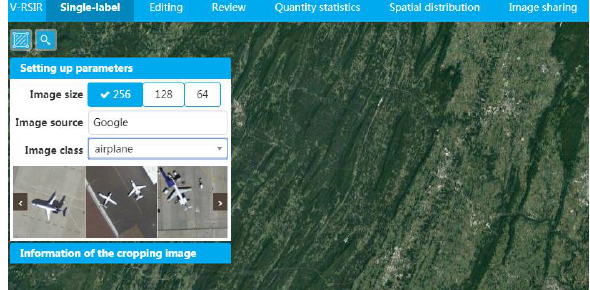
Figure 2. Interface of image single-label and cropping